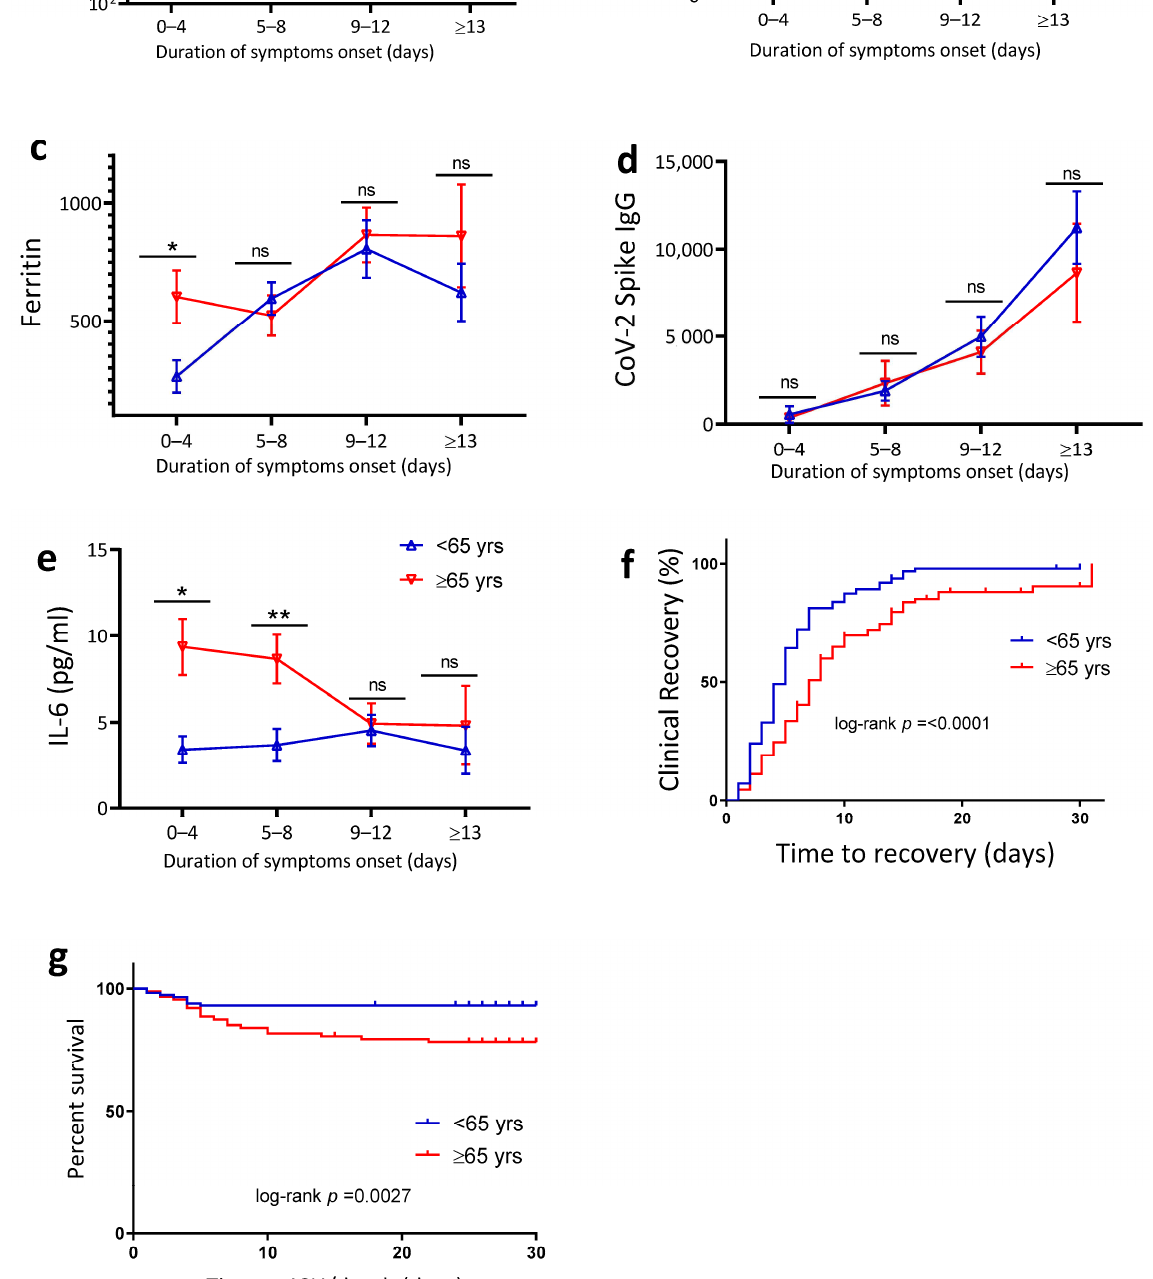
Figure 1. Age is associated with increased SARS-CoV-2 viral load, inflammatory response, and delayed clinical recovery. Oropharyngeal swabs and serum sample of SARS-CoV-2 patients were analyzed for viral titer, biochemistry, IgG, and cytokine level. ( a ) Quantification of patients SARS-CoV-2 viral load by droplet PCR (ddPCR) from oropharyngeal swabs ( n = 193). ( b ) Serum CRP and ( c ) serum ferritin level were determined using clinical-based biochemistry assay ( n = 193).